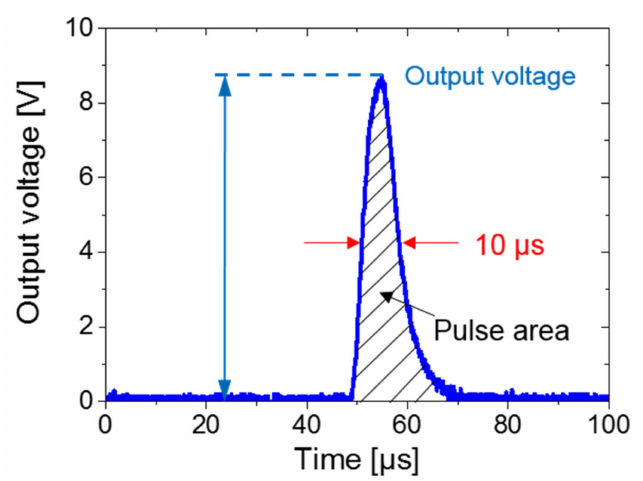
Figure 3. Pulse signal waveform from the Wiegand